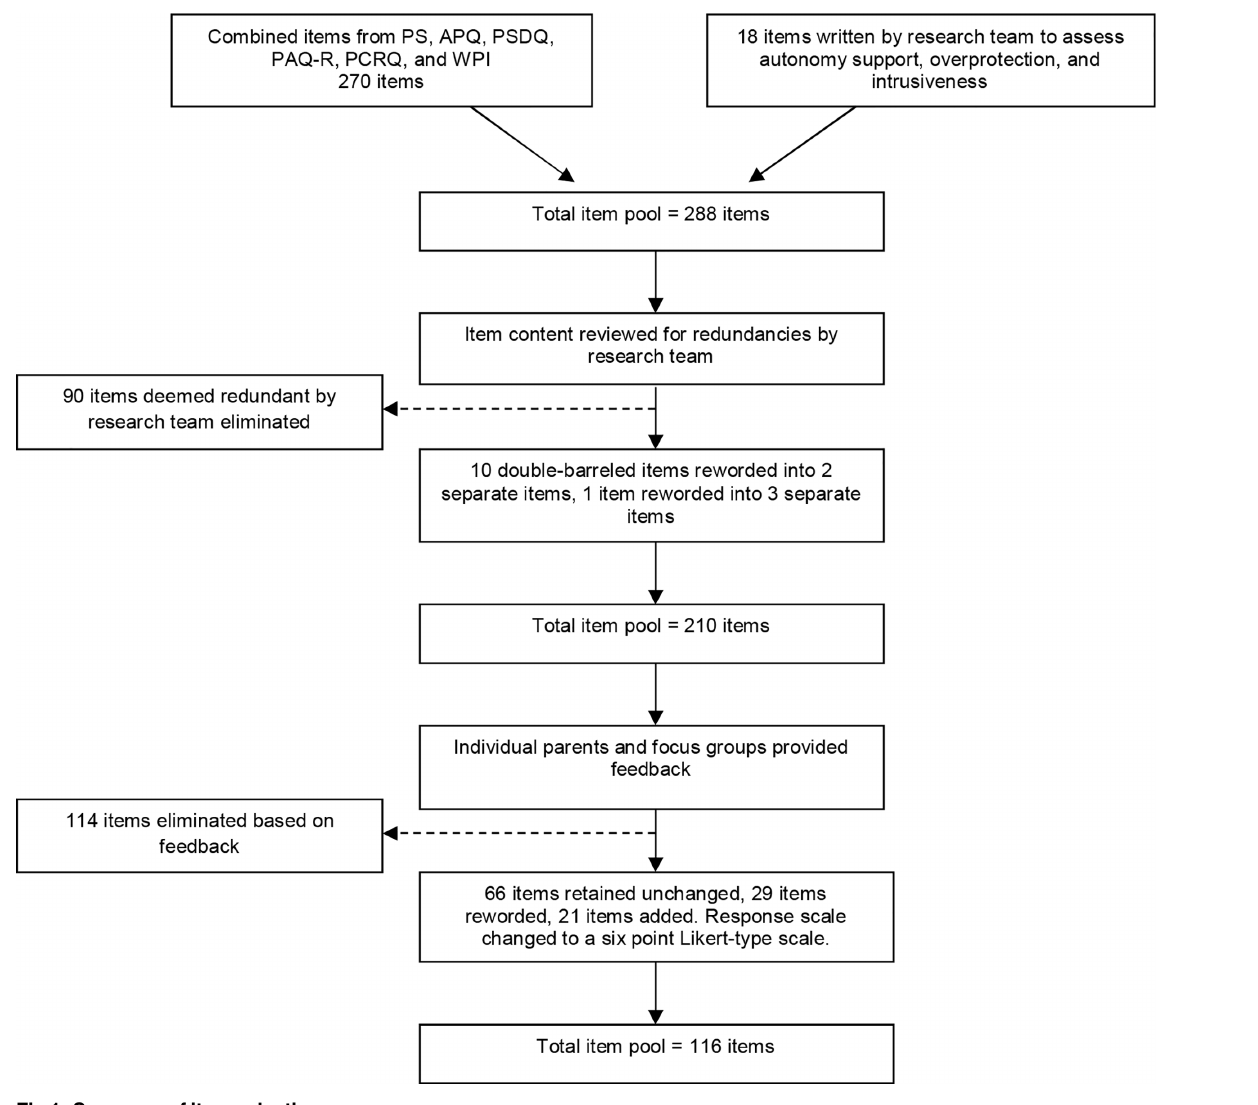
Fig 1. Summary of item selection